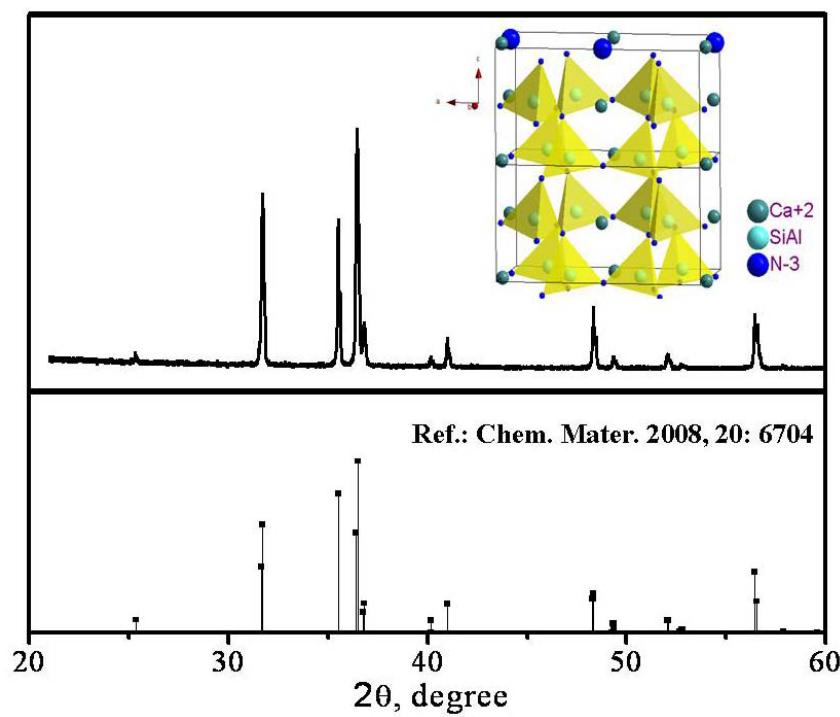
Figure 25. XRD pattern of (Sr,Ca)SiAlN